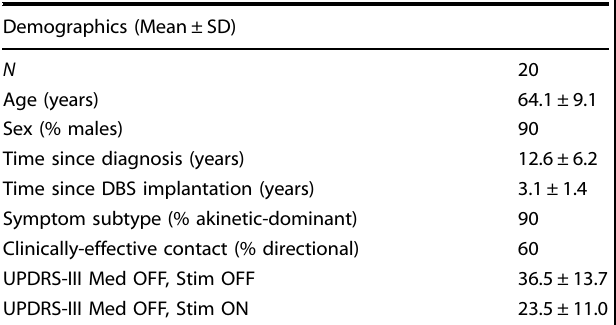
Table 1. Patient demographics and clinical information for fi nal analyzed cohort.